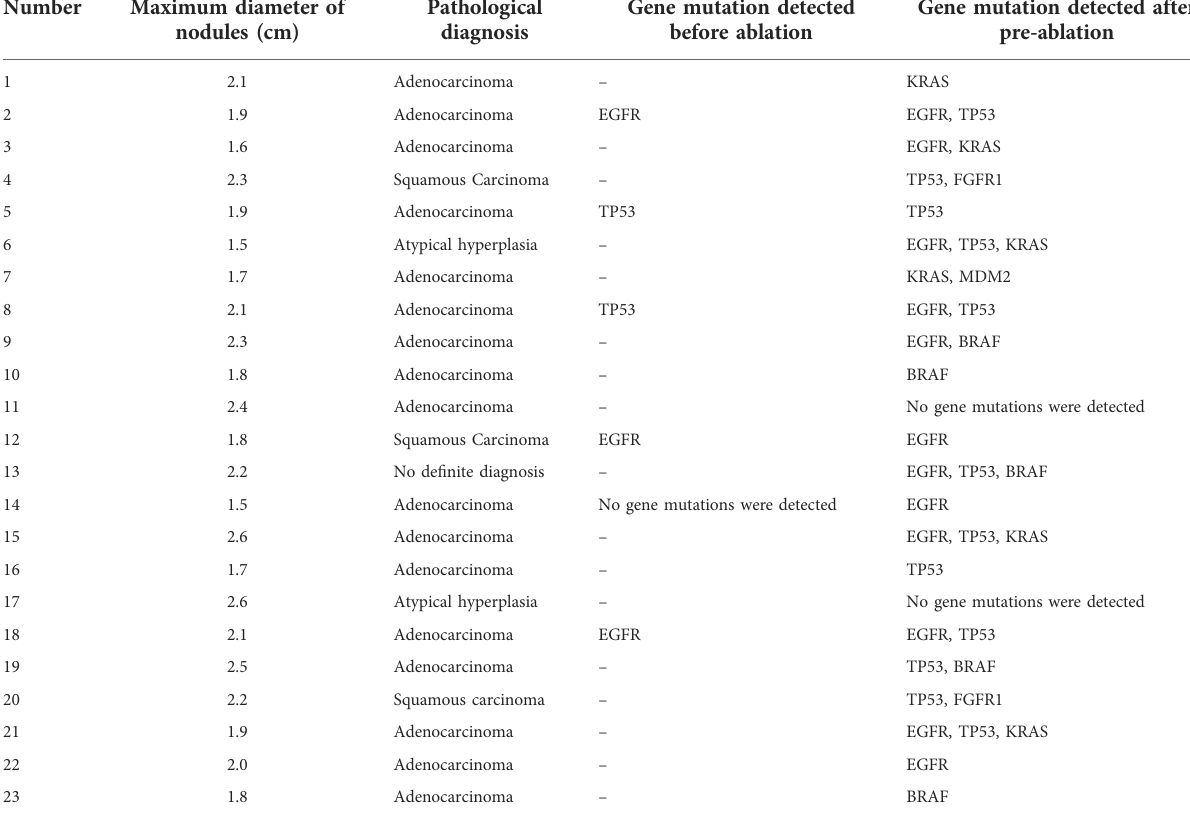
TABLE 3 Genetic test results of 23 cases in multiple multifocal ablation combined with biopsy